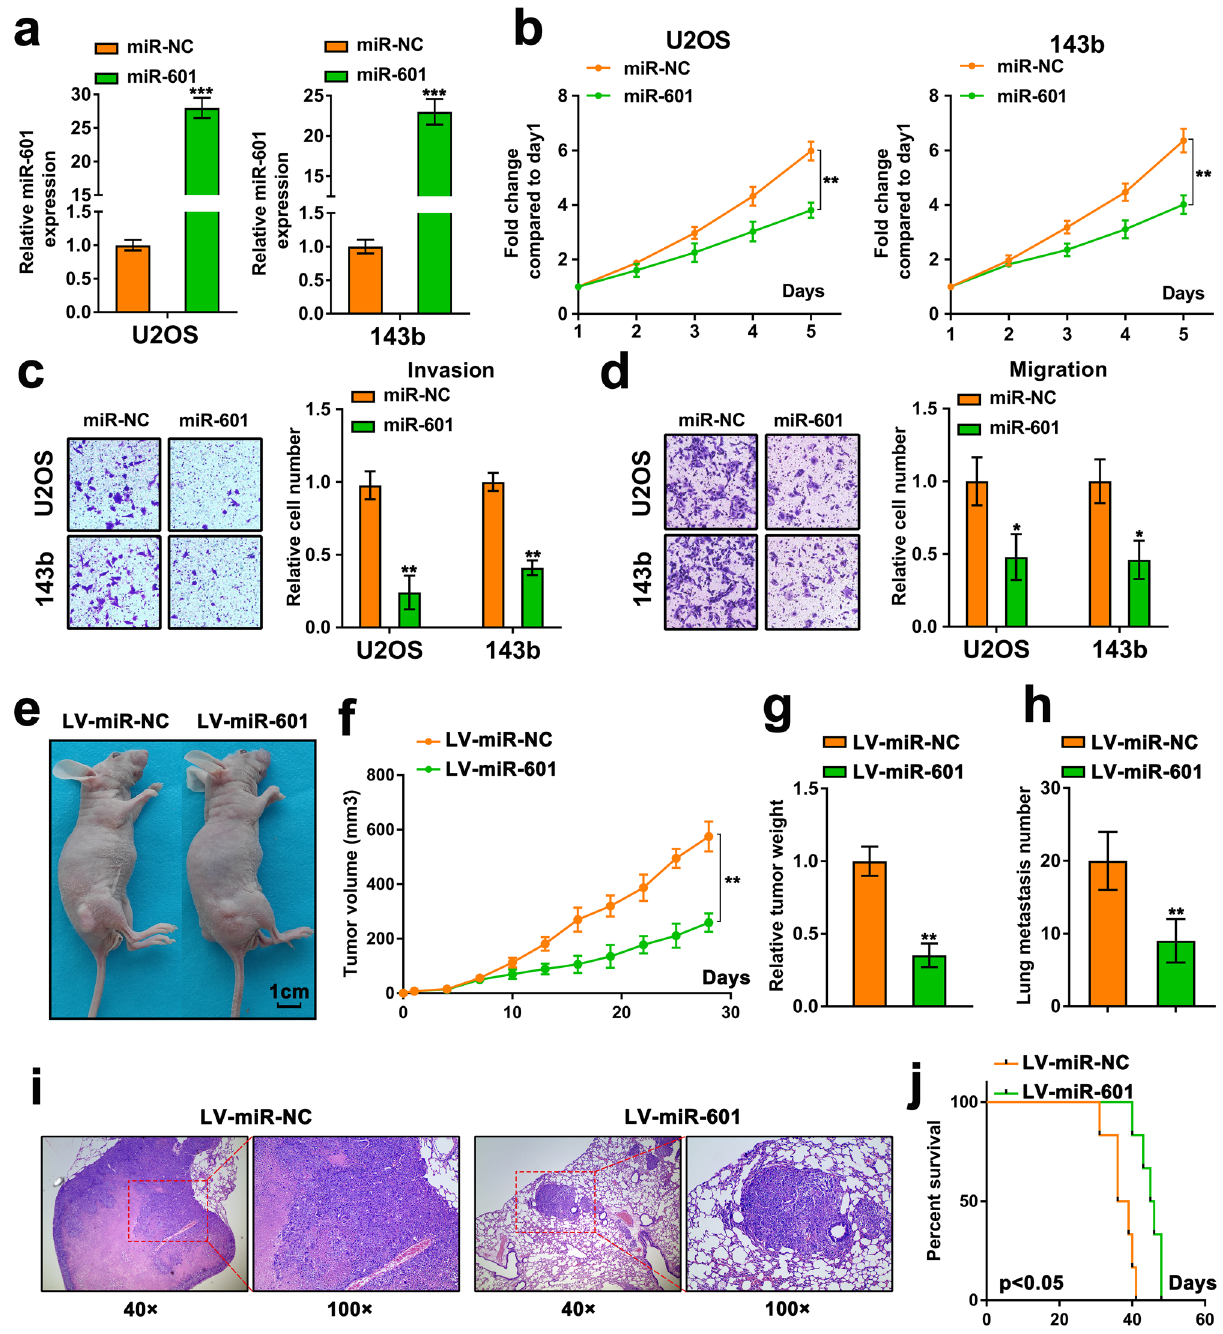
Figure 2. Overexpression of miR-601 promotes proliferation and metastasis of OS cells. ( a ) The miR-601 expression was evaluated by RT-qPCR assay in U2OS and 143b cells with miR-601 overexpression. ( b ) The proliferation of U2OS/143b cells was measures by the MTT experiment. ( c, d ) The invasion and migration abilities of U2OS and 143b cells was assessed by the transwell assay. ( e ) The nude mice (6 per group) were subcutaneously injected with U2OS cells transfected with lentivirus vector carrying the miR-601 sequence (LV-miR-601) or negative control (LV-miR-NC). ( f, g ) The volume and weight of xenograft tumor of nude mice. ( h, i ) U2OS cells, transfected with lentivirus vector carrying the miR-601 sequence (LV-miR-601) or negative control (LV-miR-NC), were injected into the nude mice (6 per group) from tail vein. The metastasis on lung was assessed via H&E staining. ( j ) The survival of nude mice was